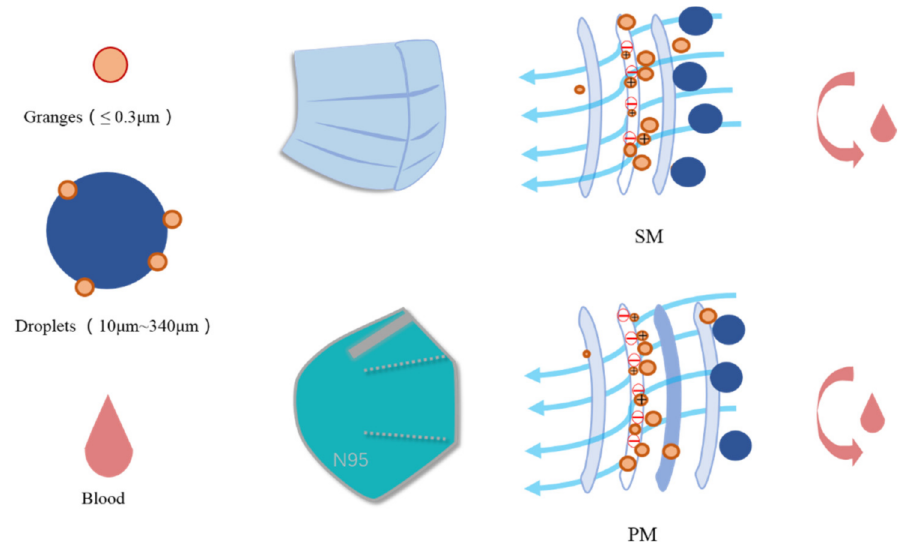
Figure 4. Diagram of mask filtration.